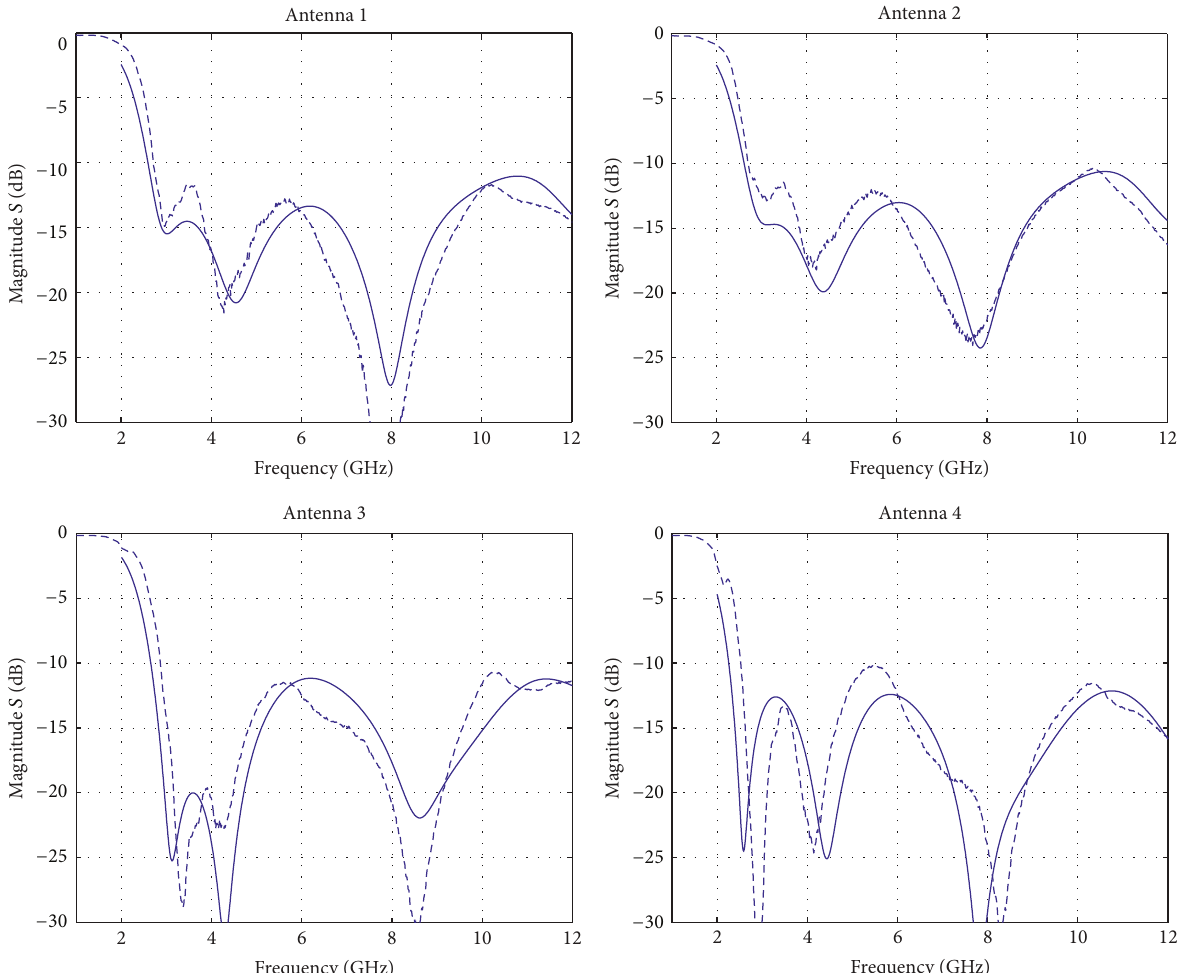
Figure 7: Magnitude of the reflection coefficient for planar antennas. Simulation: solid line. Measurement: dashed line.